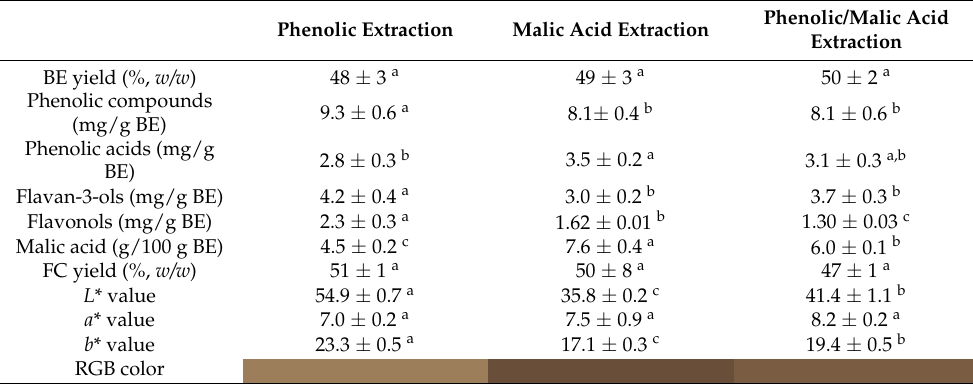
Table 4. Extraction yields, contents of phenolic compounds and malic acid in the bioactive extracts (BEs), and color of the fiber concentrates (FCs) obtained from quince peel under optimal extraction conditions defined for phenolic compounds, malic acid, and both